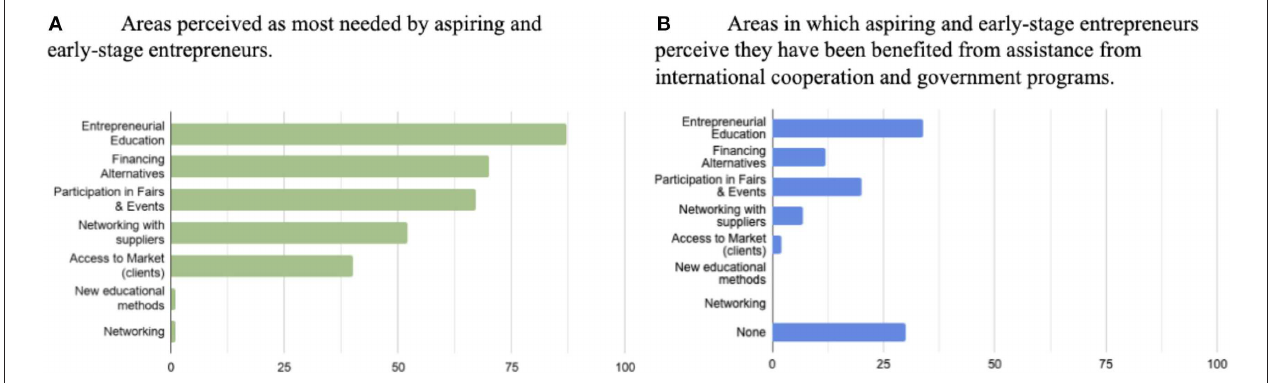
FIGURE 1 | Perception toward the needs from aspiring and early-stage entrepreneurs aged 16–22 in Bolivia vs. perception toward assistance received from international cooperation and government programs (Moed, 2018). Part A : Areas perceived as most needed by aspiring and early-stage entrepreneurs. Part B : Areas in which aspiring and early-stage entrepreneurs perceive they have been benefited from assistance from international cooperation and government programs.